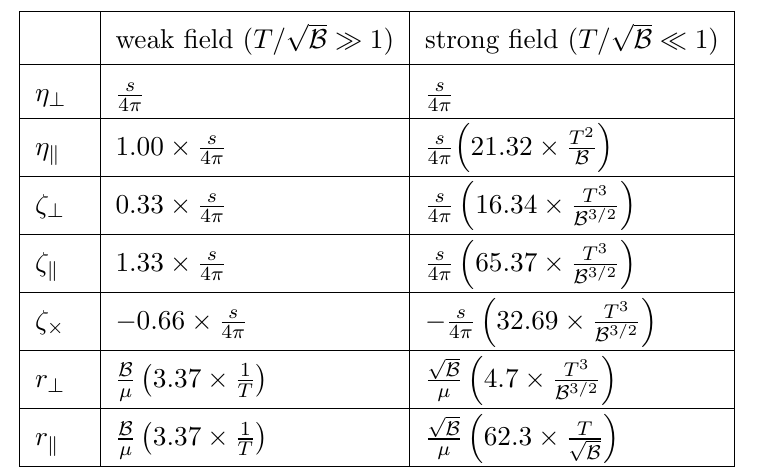
Figure 2 . The plots of (dimensionless) (cid:12)rst-order transport coe(cid:14)cients as a function of T=